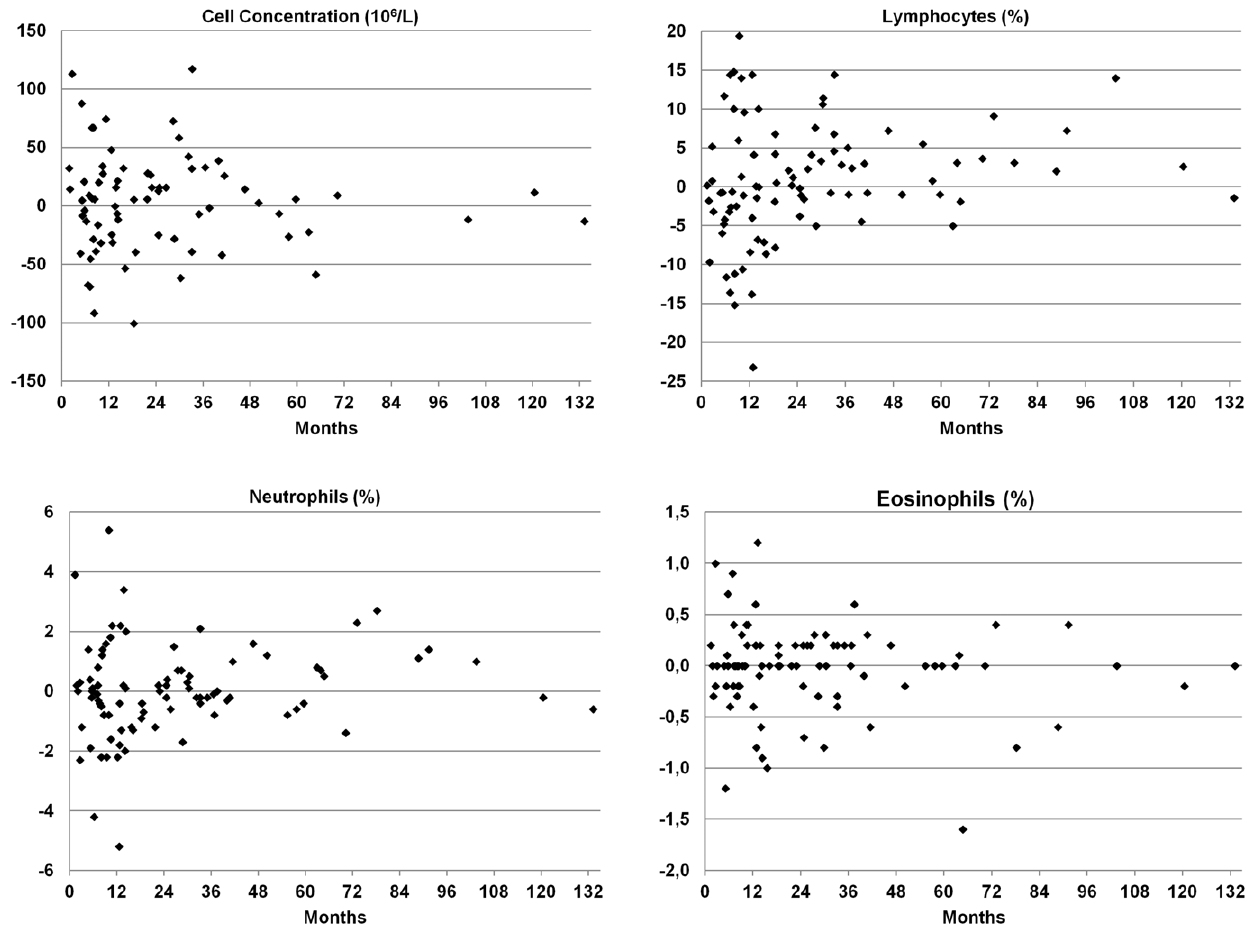
Figure 3. Change in bronchoalveolar lavage fluid findings from first BAL (y-axis) related to time between investigations (x-axis) in healthy never-smoking subjects.